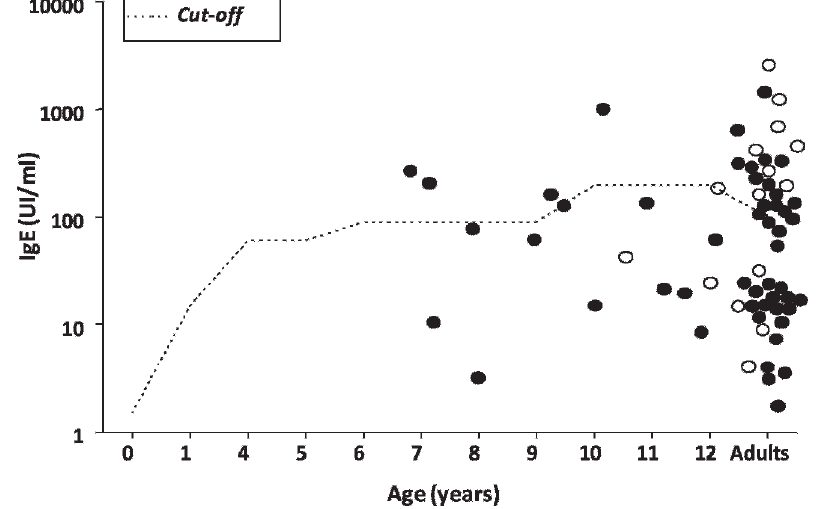
Figure 1 - IgE serum concentrations in 69 patients with juvenile systemic lupus erythematosus. Individual values were plotted in the graph with normal values for IgE obtained from a standard curve previous established 21 . White circles represent patients WITH atopic manifestations, while black circles represent patients WITHOUT atopic manifestations.